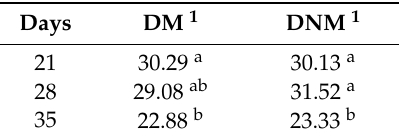
Table 3. The arrangement of Duncan test results concerning di ff erences in DM and DNM due to the days of tissue